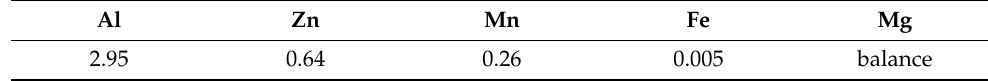
Table 1. The chemical composition of the AZ31 magnesium